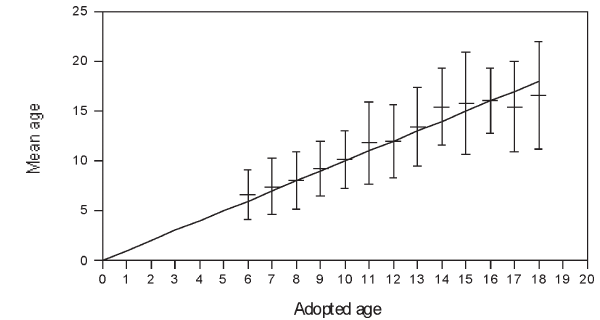
F IG . 5. – Age bias plots. The mean age recorded +/- 2stdev of all age readings (otolith and scales) is plotted against the adopted